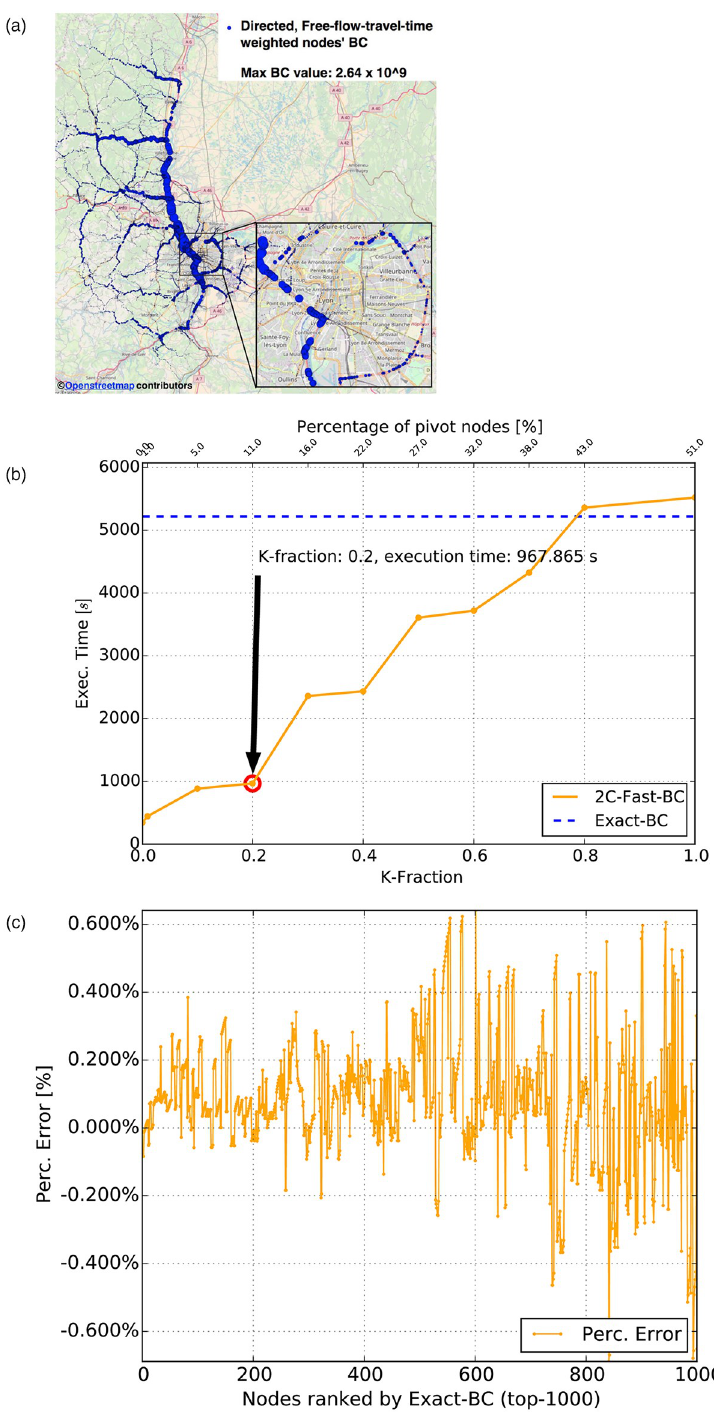
Fig 9. Directed graph weighted with discretized free-flow-travel-times. (a) Nodes’ BC values (circle size proportional to node’s BC) (b) Execution times (W2C-Fast-BC and Brandes BC) with 10 cores (c) Percentage error of W2C-Fast-BC with K-fraction = 0.2